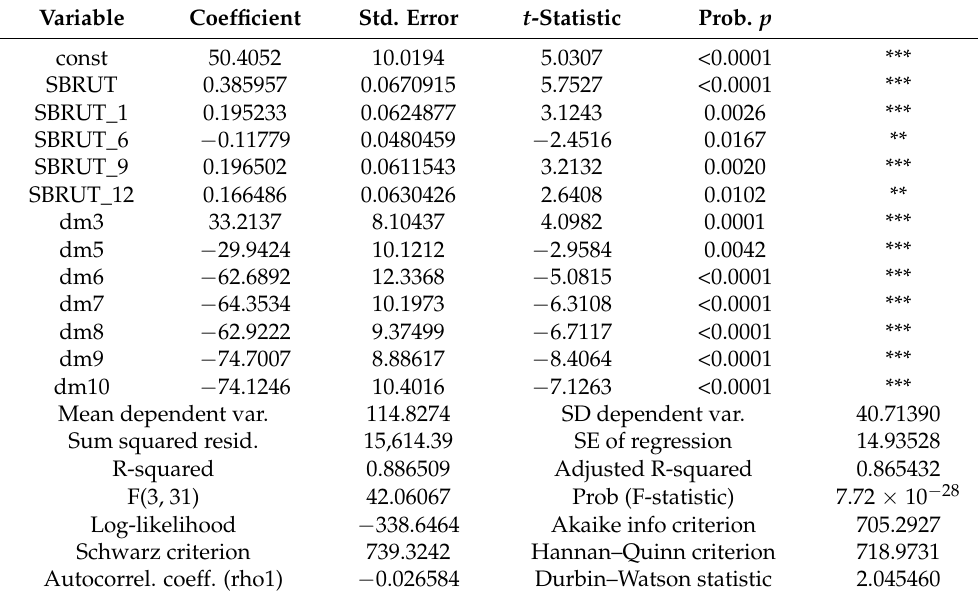
Table A4. Dependent variable: amount of cash inflows in period t (CASH) (observation 2001:01– 2007:12 (N = 84)).